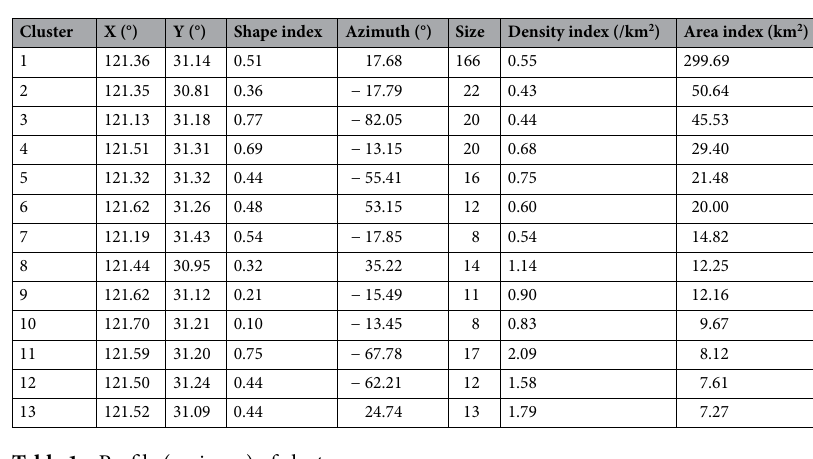
Table 1. Profile (variance) of